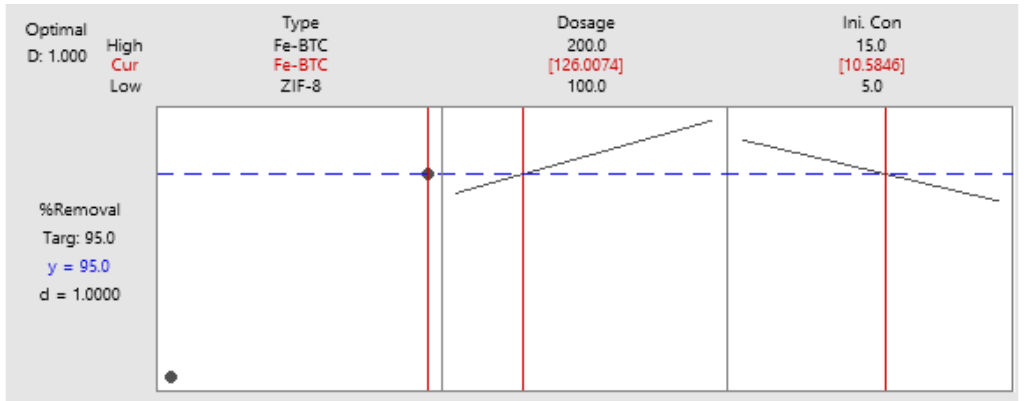
Figure 15. Process optimization curve for a target value of 95% removal of MO on Fe-BTC.